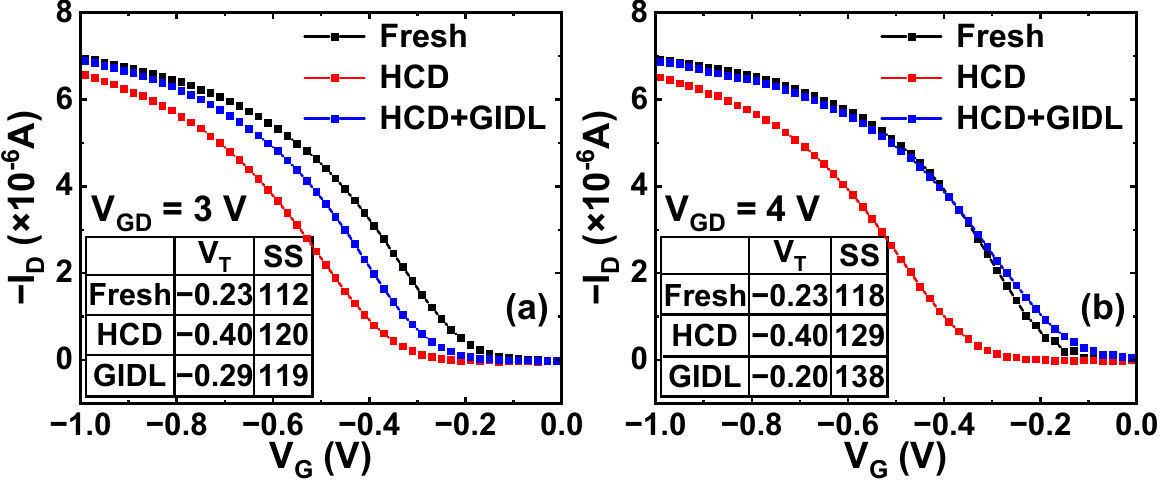
Figure 4. Measured pulse-IV characteristics of p-FinFETs at the initial state, after 200 s HCD, and after 1 ks GIDL repair for ( a ) V GD = 3 V: V G,GIDL = 0.5 V, V D,GIDL = − 2.5 V and ( b ) V GD = 4 V: V G,GIDL = 1.5 V, V D,GIDL = − 2.5 V. HCD stress: V G,STR = V D,STR = − 2 V.